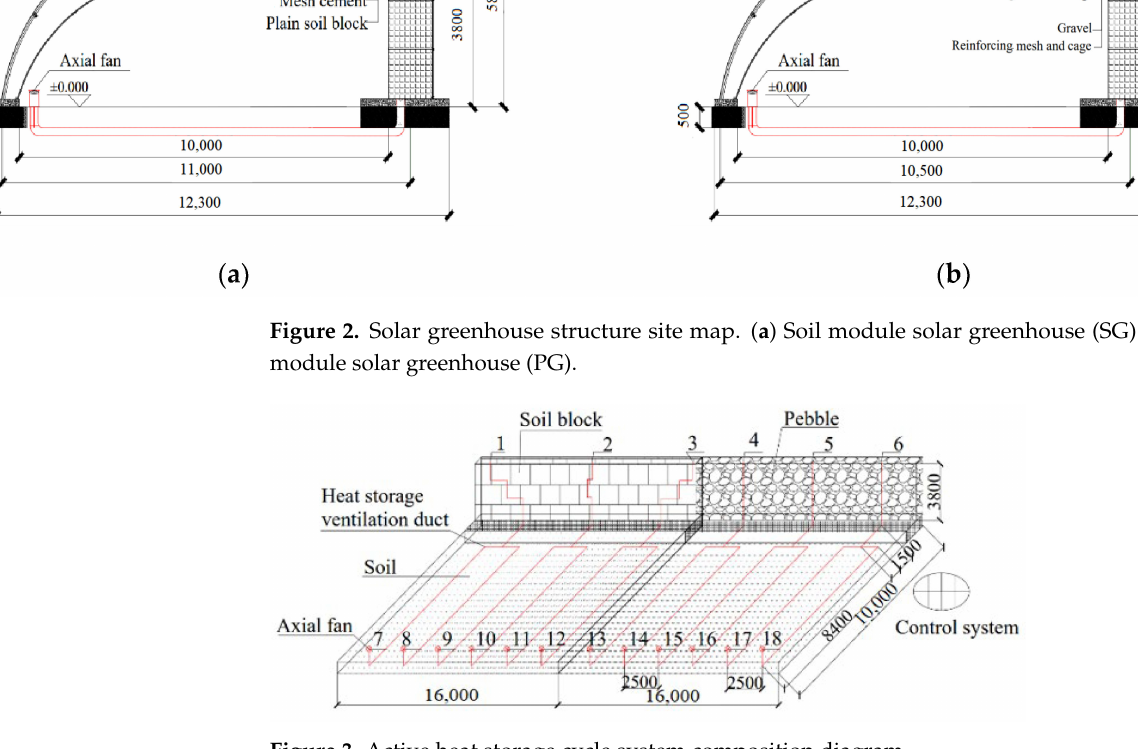
Figure 3. Active heat storage cycle system composition